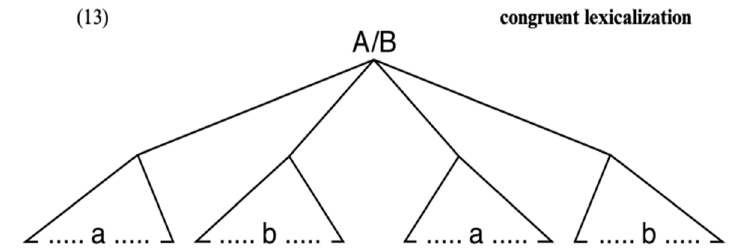
Figure 2. Congruent lexicalisation (Muysken 2000, p. 8).